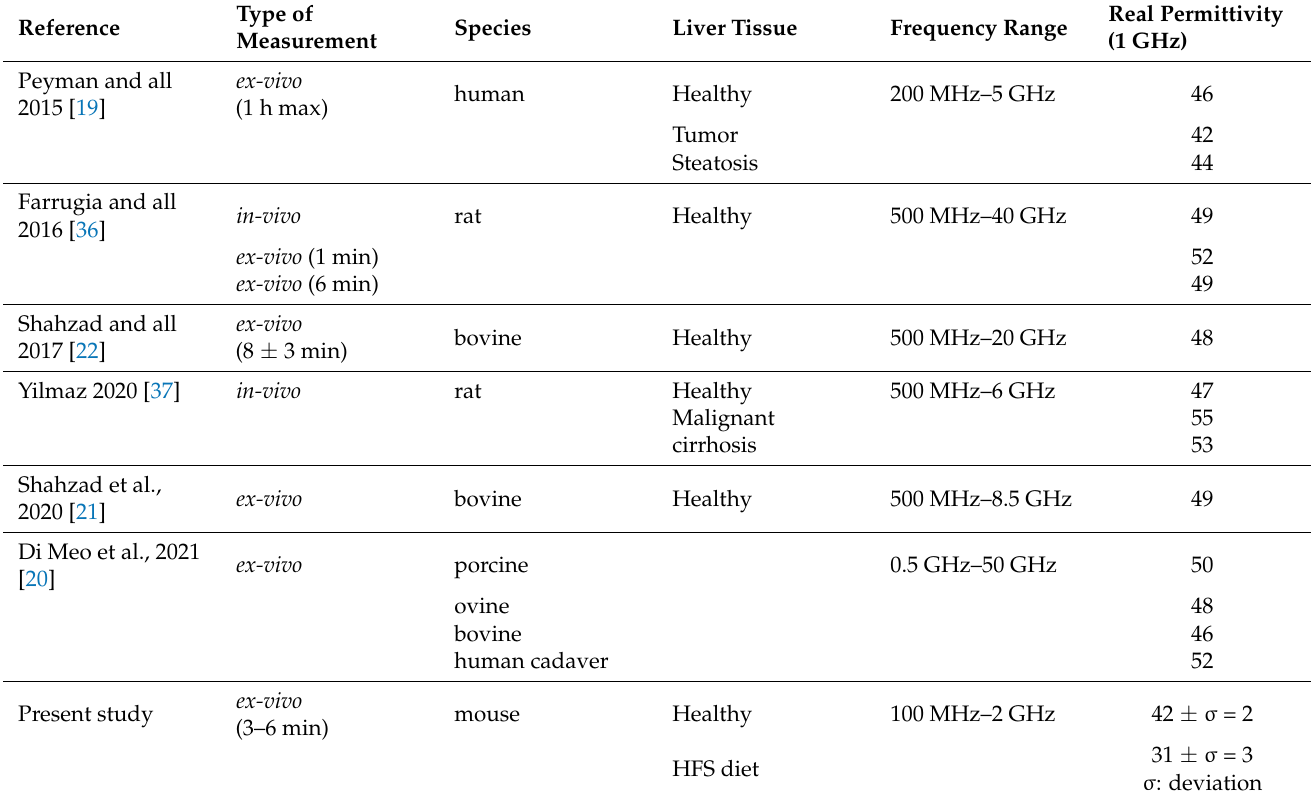
Table 1. Dielectric properties of hepatic tissues from recent literature and the present